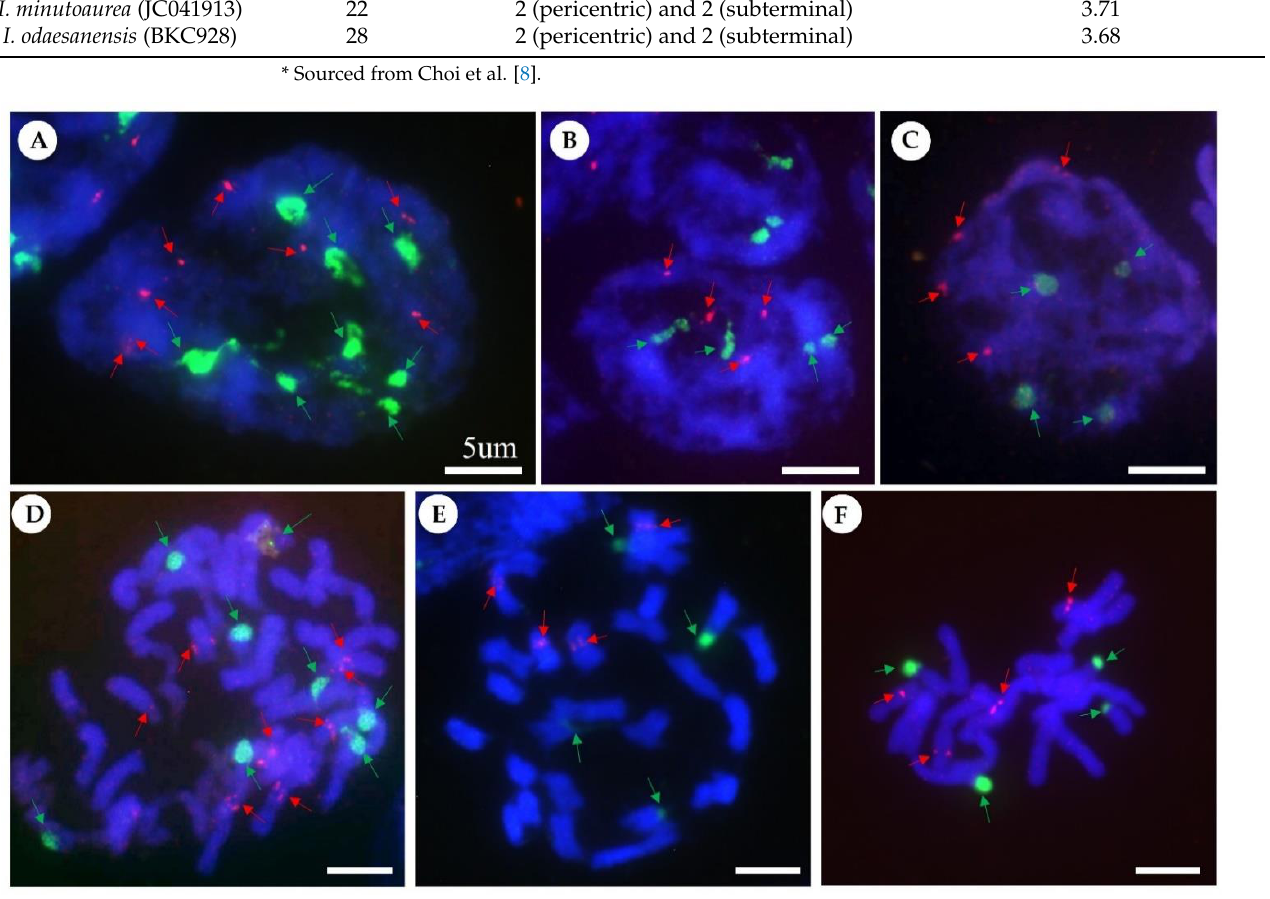
Figure 2. Localization of 5S and 18S rDNA loci in nuclei ( A – C ) and metaphase ( D – F ) of chromosomes of the three Iris species. Fluorescence in situ hybridization (FISH) was performed with 5S rDNA (red signals) and 18S rDNA (green signals) as probes. ( A , D ) Iris koreana , ( B , E ) I. odaesanensis , and ( C , F ) I. minutoaurea . Scale bar = 5 µm. Table 1. Investigated species of Iris series Chinenses with collection numbers, 5S and 18S rDNA sig- nal numbers and localization, chromosome numbers and genome size estimates.